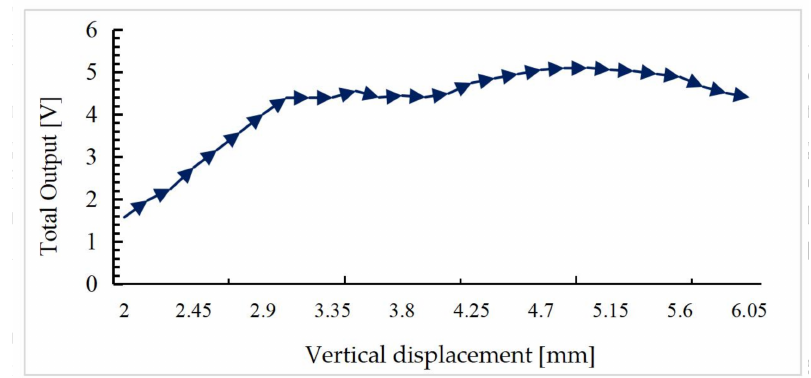
Figure 13. The total voltage versus vertical displacement.